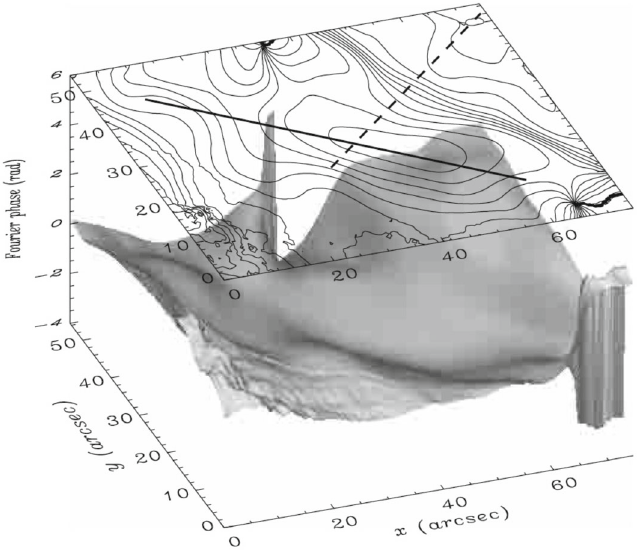
Fig. 26 Fourier phase associated to a period around 75 min (that is, the one corresponding to the largest peak in the Fourier spectrum) for the rectangular region selected in Fig. 23, both as a contour and as a surface plot. The selected paths are also displayed with continuous and dashed straight lines. Note that cuts of the Fourier phase along these two paths give rise to the Fourier phase displayed in Figs. 24 and 25. Image reproduced with permission from Terradas et al. (2002), copyright by